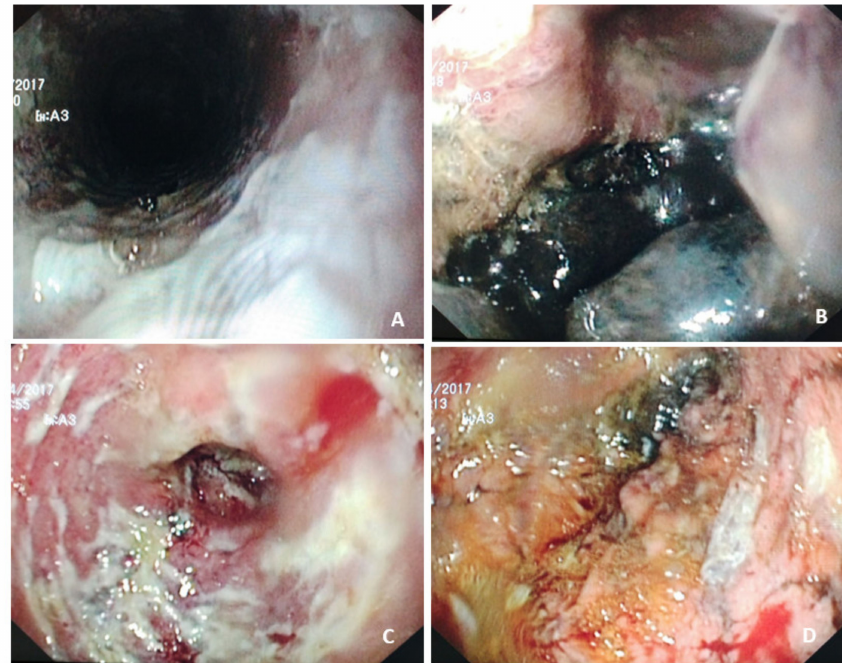
Figure 5. High-grade injuries caused by caustic ingestion. The images correspond to an 82-year- old woman who ingested hydrochloric acid for suicidal purposes due to severe pain associated with polyarthritis and significant dependence for activities of daily living. ( A ) Esophagus. From the proximal esophagus, superficial ulcers can be seen extending around the entire circumference (Zargar IIb). ( B ) Gastric fundus. Remains of gastric contents are observed on an unstructured and friable mucosa, scattered ulcers, and extensive necrosis in the distal portion of the greater curvature. ( C )Antrum and pylorus. Edematous and friable antral mucosa with deep ulcers with a fibrinous base. ( D ) Gastric necrosis. The area of mucosa corresponds to a segment of approximately 4 cm in the greater curvature of necrotic appearance (Zargar IIIb). This case highlights the pathogenic mechanisms of corrosive lesions induced by strong acids. Typically, as the acid flows along the lesser curvature of the stomach toward the pylorus, pylorospasm impairs emptying into the duodenum, producing stagnation and injury that is more prominent in the antrum. Courtesy of S á nchez